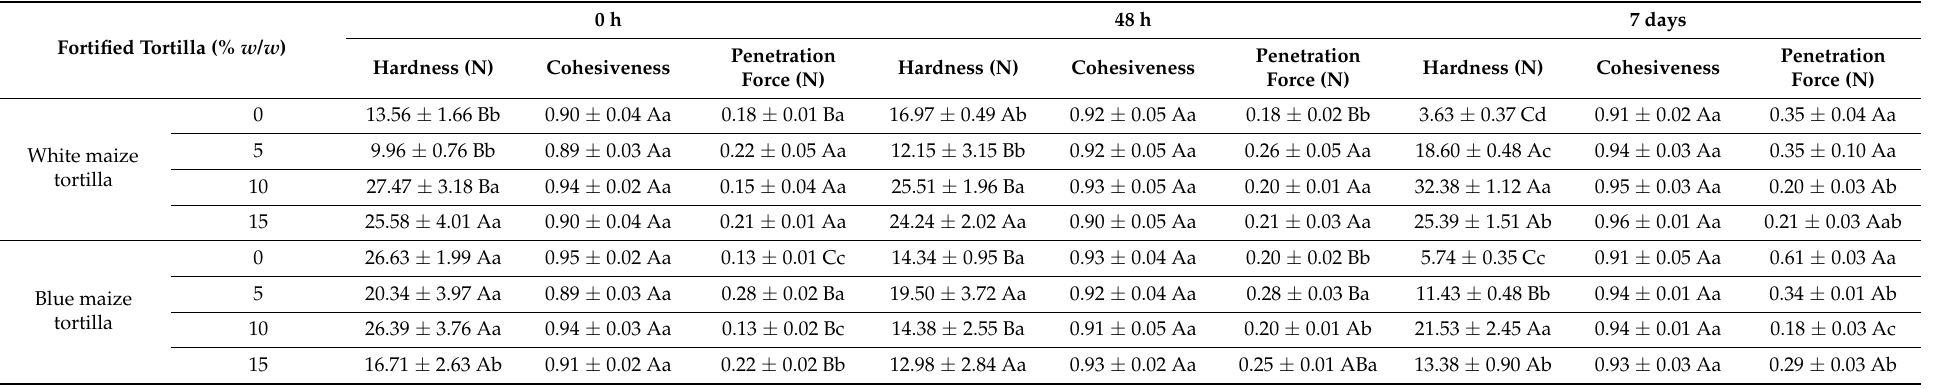
Table 4. Texture analysis of tortillas fortified with optimized chickpea hydrolysate with DPPIV inhibitory activity obtained from isolated protein using bromelain at different ratios and at different storage